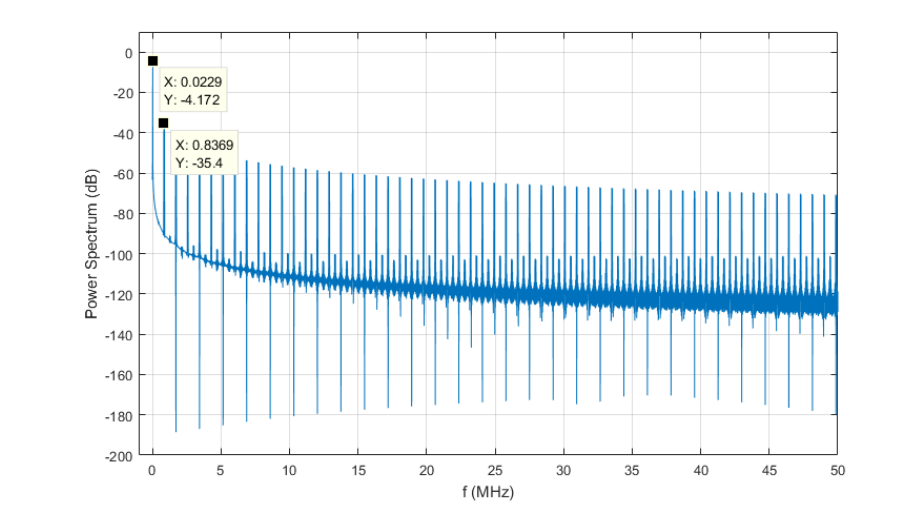
Figure 10. Sidelobe level as a function of fractional quantum q = 1